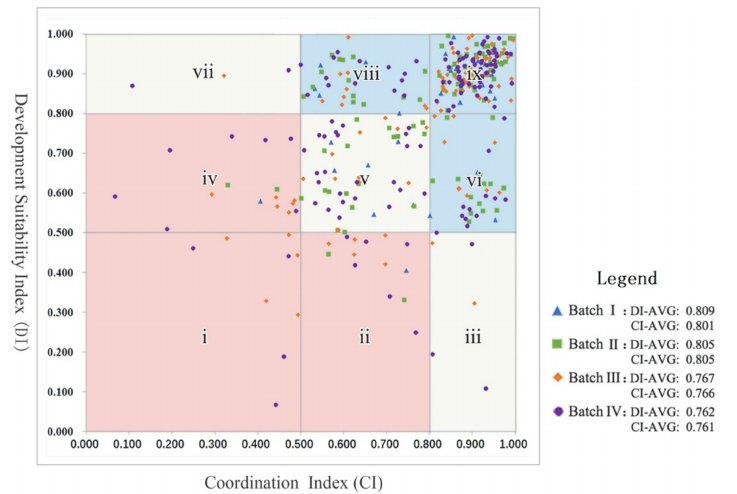
Figure 11. The GE matrix diagram of the development suitability and coordination of batches I–IV of pilot FHBs in